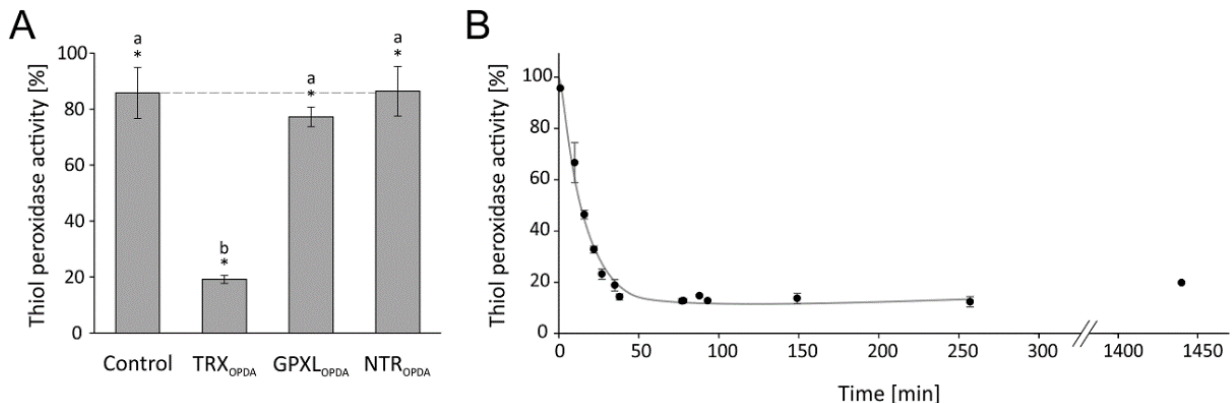
Figure 7. Relative glutathione peroxidase-dependent H 2 O 2 detoxification after preincubation of single components with OPDA. ( A ) In total, 20 µ M reduced and desalted recombinant protein (NTRA, TRX-h3 or GPXL8) was preincubated with 150 µ M OPDA for 1h. The pretreated proteins were added to the otherwise untreated assay components as described before: 200 µ M NADPH, 1 µ M NTRA, 0.25 µ M TRX-h3, 3 µ M GPXL8 and 300 µ M H 2 O 2 . To ensure comparative results, the final OPDA concentration in the reaction mix was 22.5 µ M OPDA always. The GPXL8 activity was measured and related to measurements in absence of OPDA but pretreated with the solvent ethanol. Data are means ± SD of n = 6. Significance of difference between the components was determined using ANOVA, followed by post hoc Tukey test and is marked with letters a and b. * marks significant differences to corresponding measurements without OPDA as determined by t -test ( p < 0.05). ( B ). In total, 20 µ M reduced TRX-h3 was incubated with 150 µ M OPDA and the time-dependent effect of OPDA on TRX-h3-dependent GPXL8 activity was measured for 24 h. The assay contained 200 µ M NADPH, 1 µ M NTRA, 0.25 µ M preincubated TRX-h3, 3 µ M GPXL8 and 300 µ M H 2 O 2 . Data are means ± SD of n =